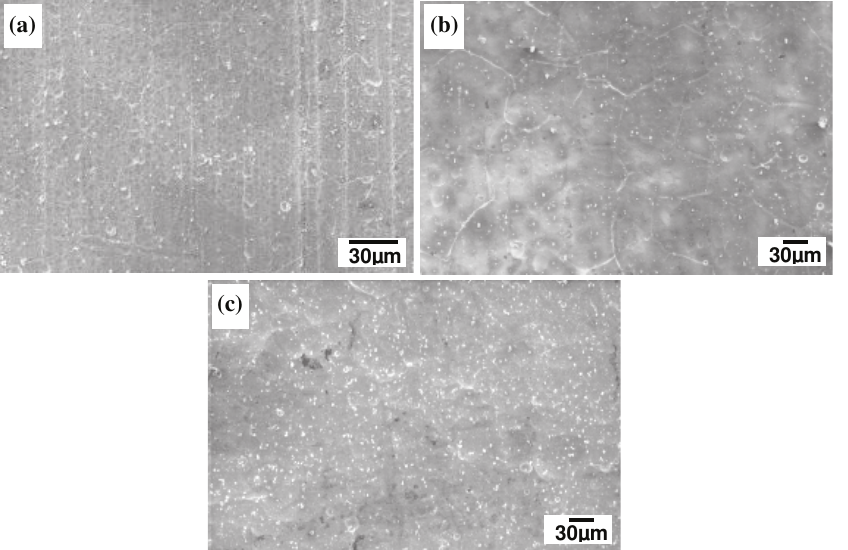
Figure 7. Surface morphology of web intersection region in extrusion samples etched for 5 min at (a) 40 ı C, (b) 70 ı C and (c) 90 ı